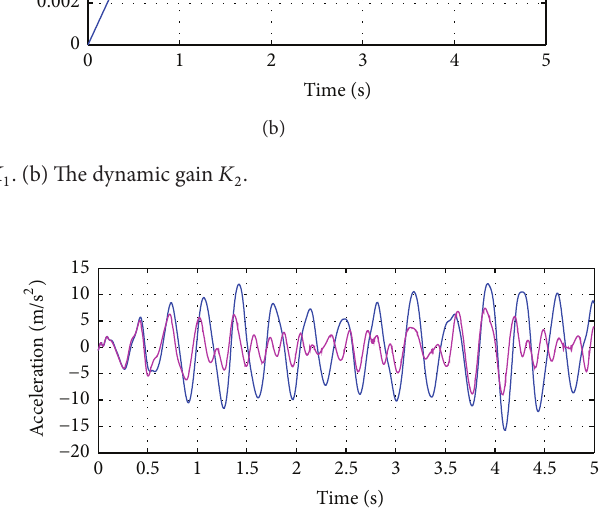
Figure 9: The sliding surface, 𝜎 . Figure 10: The sprung mass acceleration, ̈𝑧 𝑠